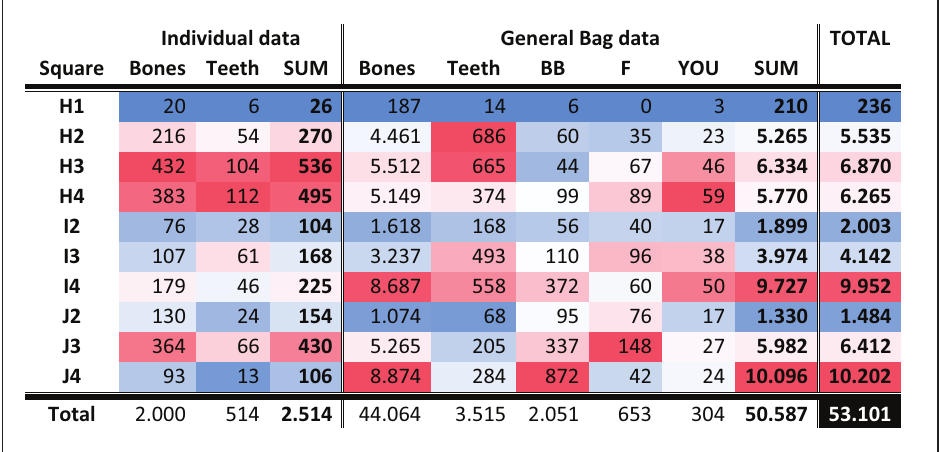
were defined: one 50 % boundary to